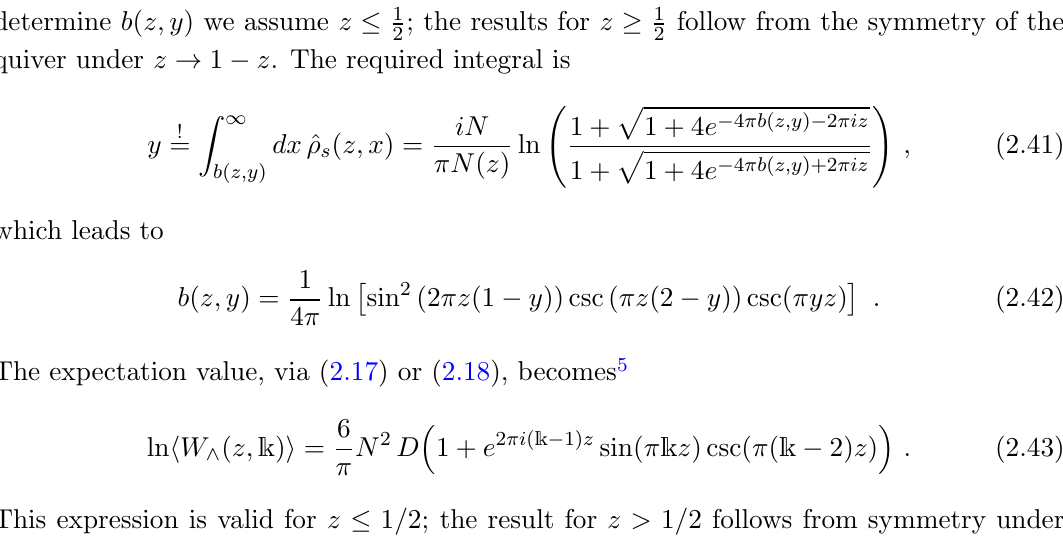
. Right: analogous plot for 2